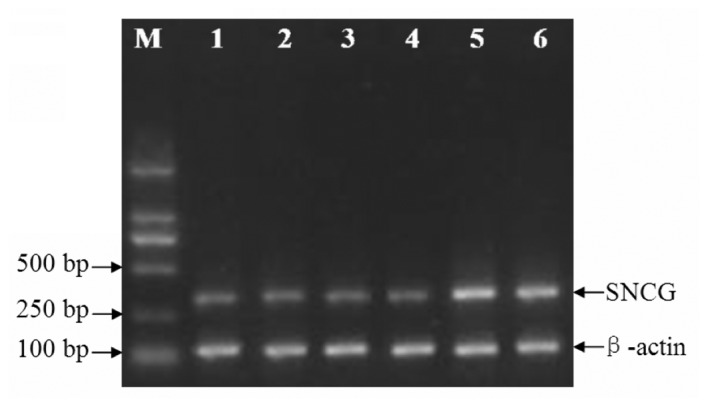
Downregulation of synuclein-γ (SNCG) detected by reverse transcription polymerase chain reaction. Lanes 1–4, SNCG-siRNA 1–4; lane 5, non-specific siRNA; lane 6, empty vector control.